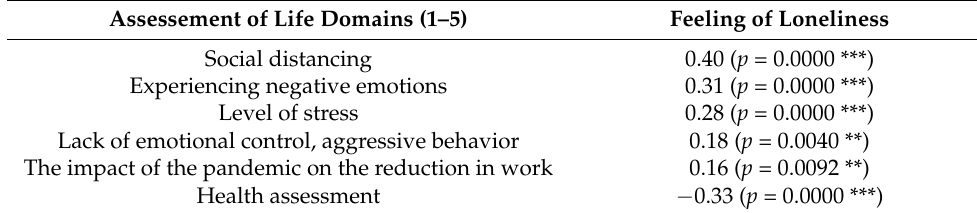
Table 6. A sense of loneliness in connection with psychosocial factors.